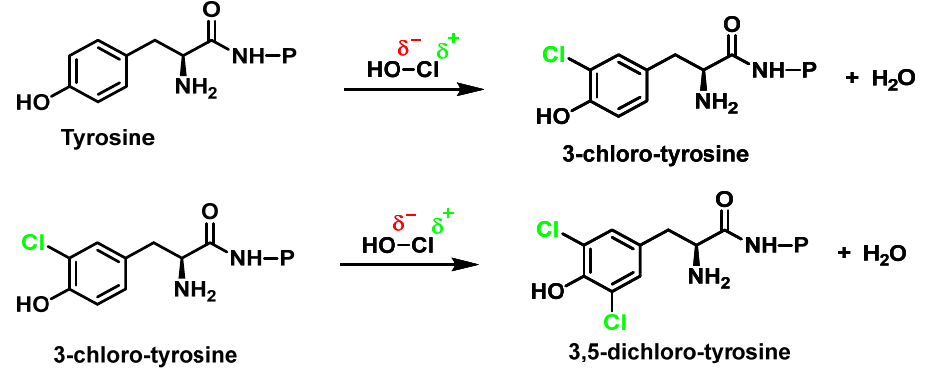
Figure 23. Reaction of P-protected tyrosine with HOCl and formation of 3-chloro- and 3,5-dichlorotyrosine derivatives.